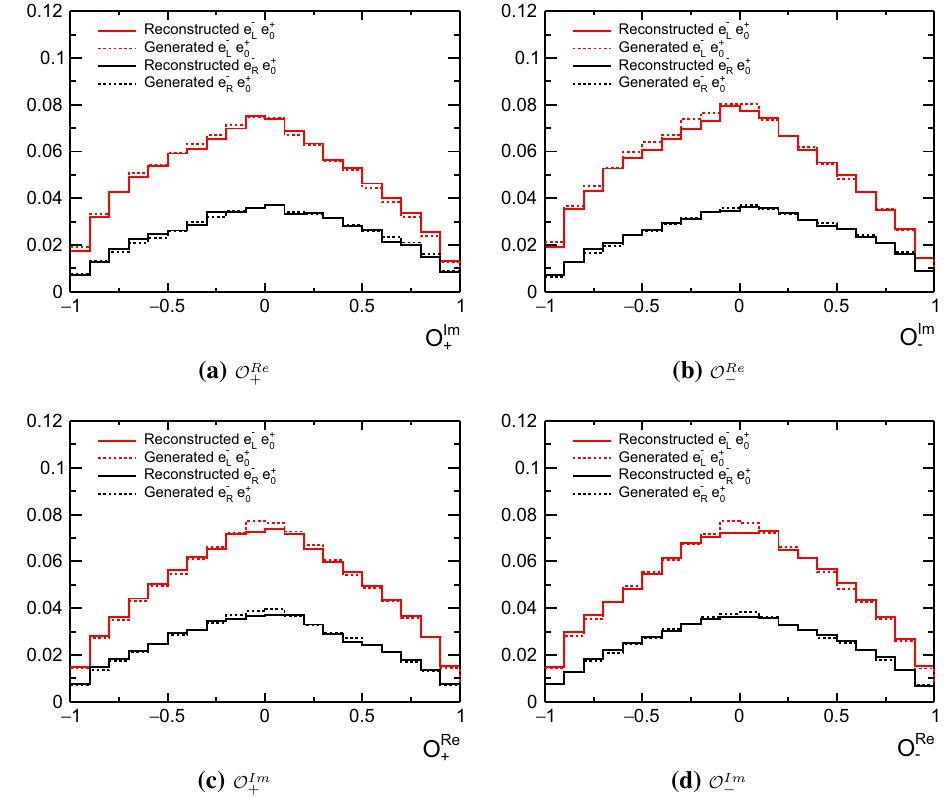
√ s = 380 GeV. electron polarization. The histogram for the left-handed electron beam is normalized to unit area. The area of the histogram for right-handed e + )corresponds polarization is scaled so as to maintain the cross-section ratios L 0 e + ) to + 80% R 0